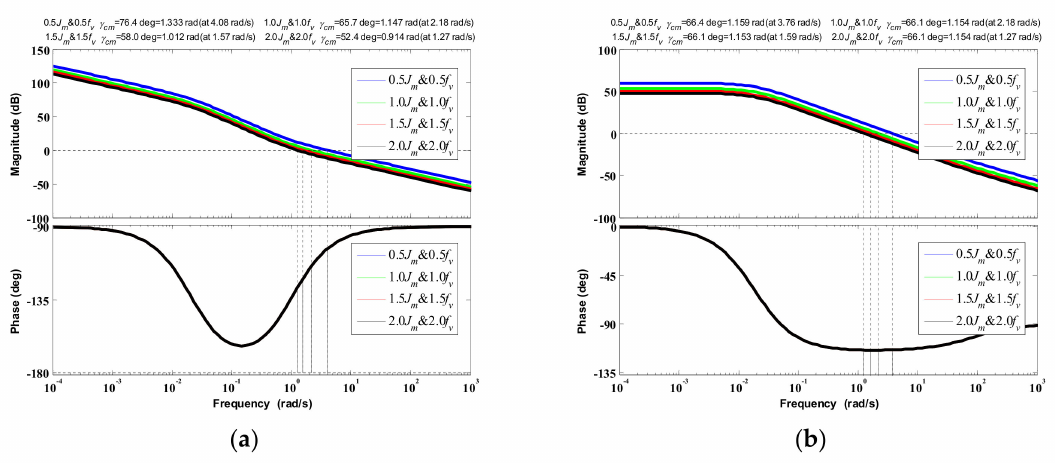
Figure 7. Bode diagrams of the speed open-loop with inaccurate mechanical model: ( a ) IOPI controller; ( b ) FOPI